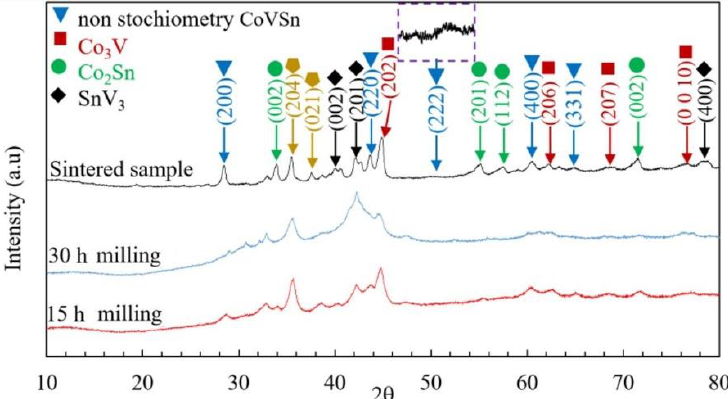
Figure 3. XRD patterns of the synthesized CoVSn compound. Figure-3. XRD patterns of the synthesized CoVSn compound. Figure-3. XRD patterns of the synthesized CoVSn compound.